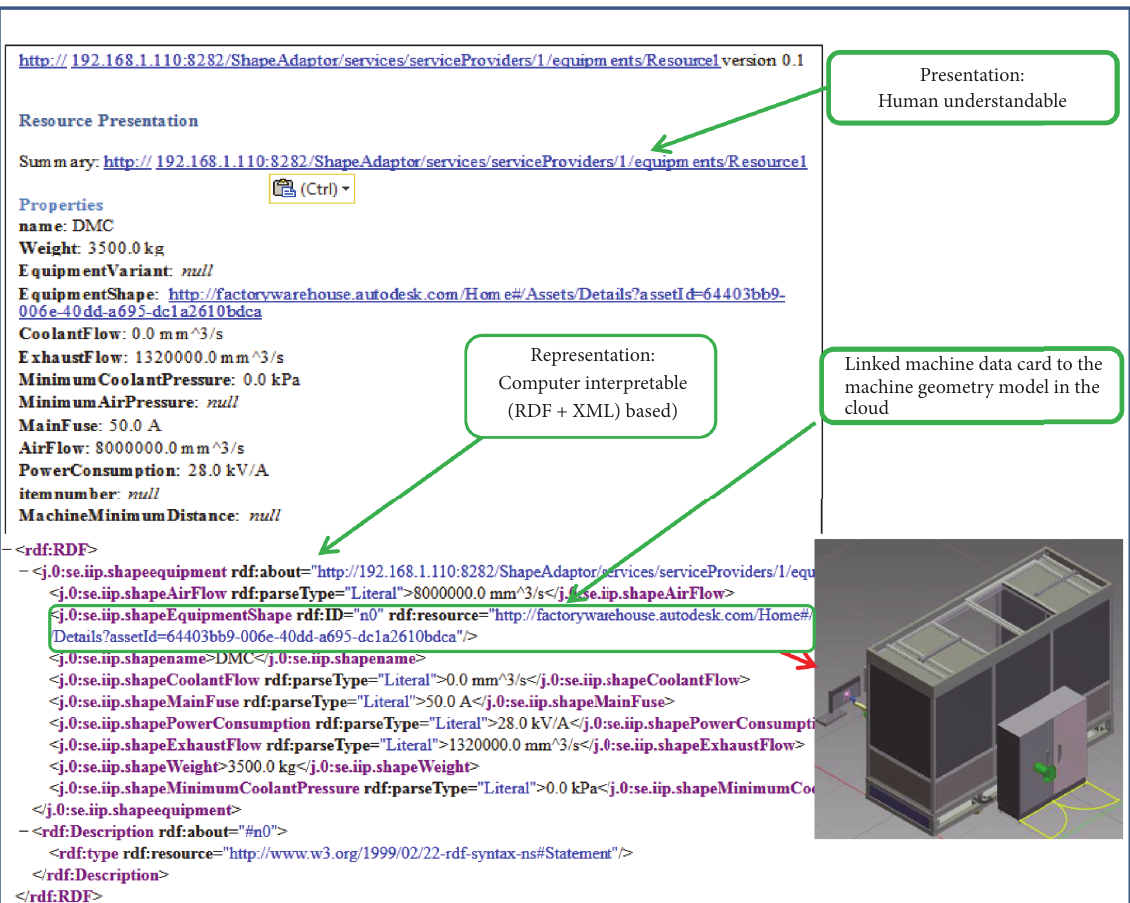
Figure 15: Presentation, representation of a machine tool technical data, and integration of these data with the machine 3D model in the